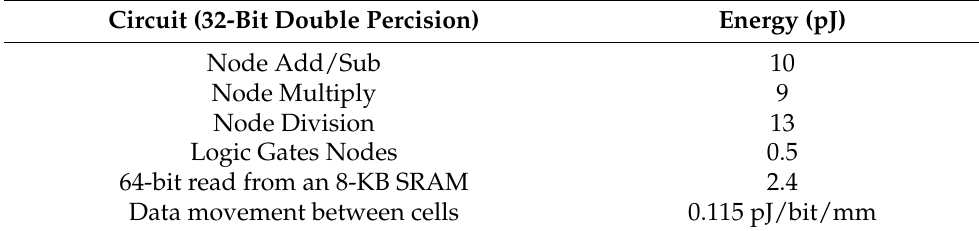
Table 3. Energy Consumption of Electronic Circuits used in MC-DeF